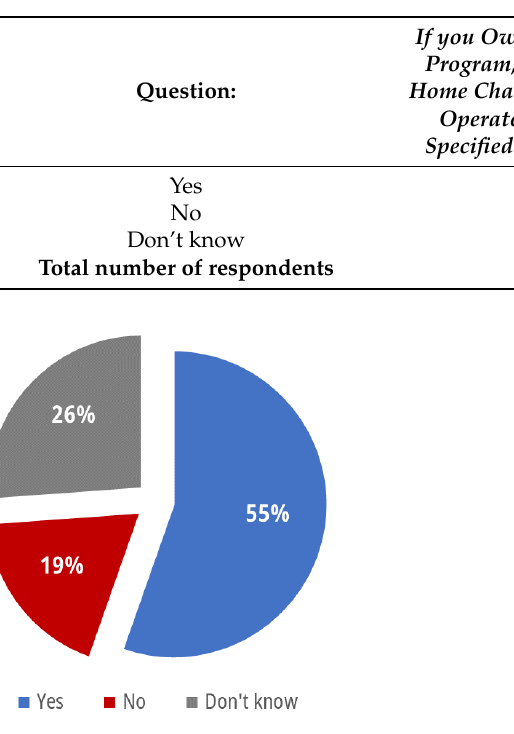
Figure A7. Responses to the question (11).